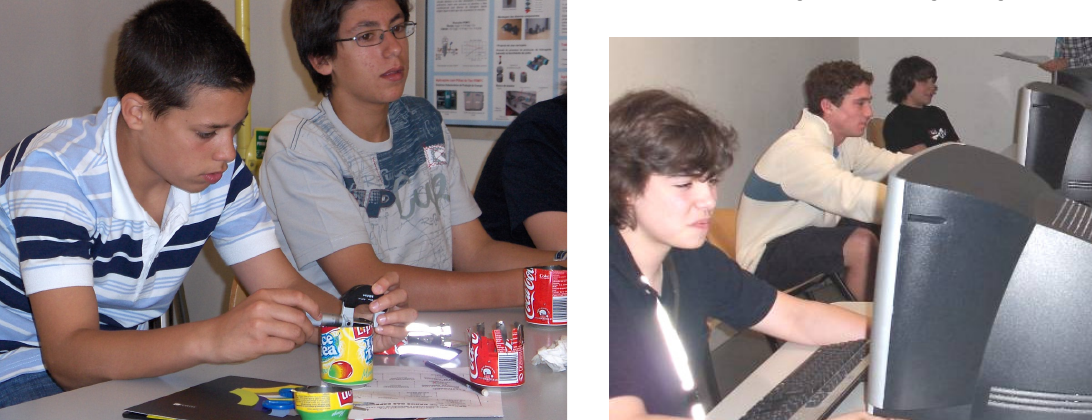
Figure 8. Working with light